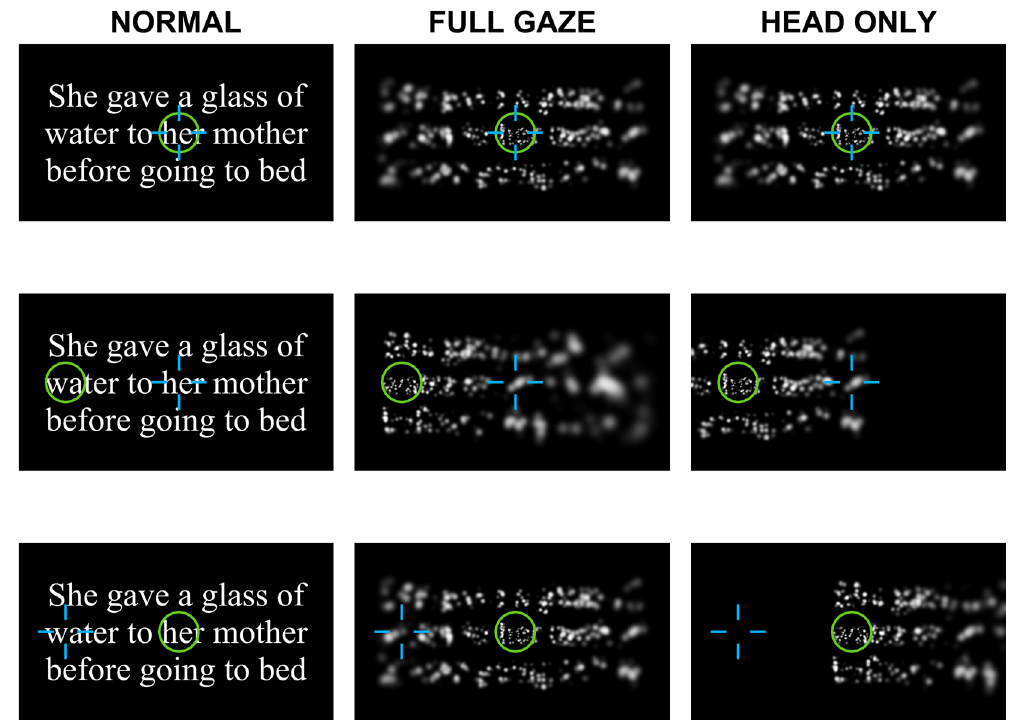
Figure 9. Screen captures from experimental conditions. Example screen shots are shown from the three conditions for an example sentence at the largest font size, 1.4 logMAR. The three columns correspond to the Normal (left column), Full Gaze (middle), and Head Only (right) conditions. The three rows correspond to three different alignment conditions for gaze (green circle) and head (blue cross) positions: the first (top row) contains the stimuli displayed under the three conditions when both the gaze and head positions are straight ahead, at the center of the screen where the subject is looking at the word /her/; the second (center) contains stimuli when the gaze is left (eyes rotated left), but the head is straight such that the subject’s gaze is on /water/, but the camera remains directed at /her/; the third (bottom) is for the gaze straight (eyes counter-rotated right) and head left such that the gaze is again on /her/, but the camera is on /water/. When the eyes are deviated from straight forward in the head, the resulting disagreement between gaze and head position creates